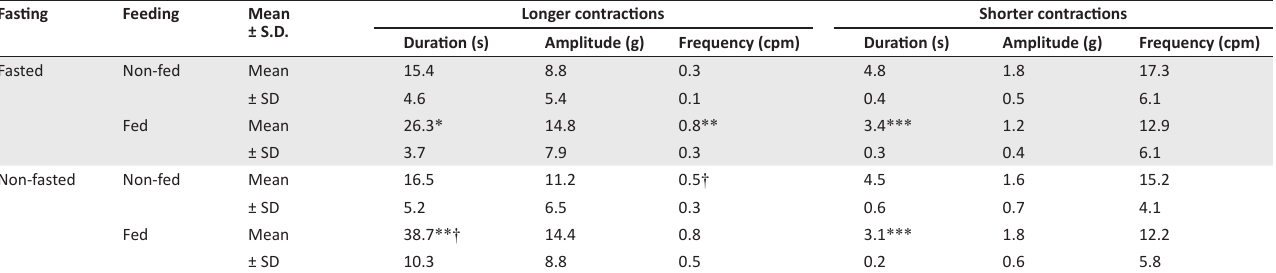
TABLE 5: Characteristics of the longer and shorter gallbladder fundic contractions recorded during phase 2-like activity of the putative gallbladder migrating myoelectric complex in various feeding conditions. Fasting Feeding Mean Longer contractions Shorter ± S.D.